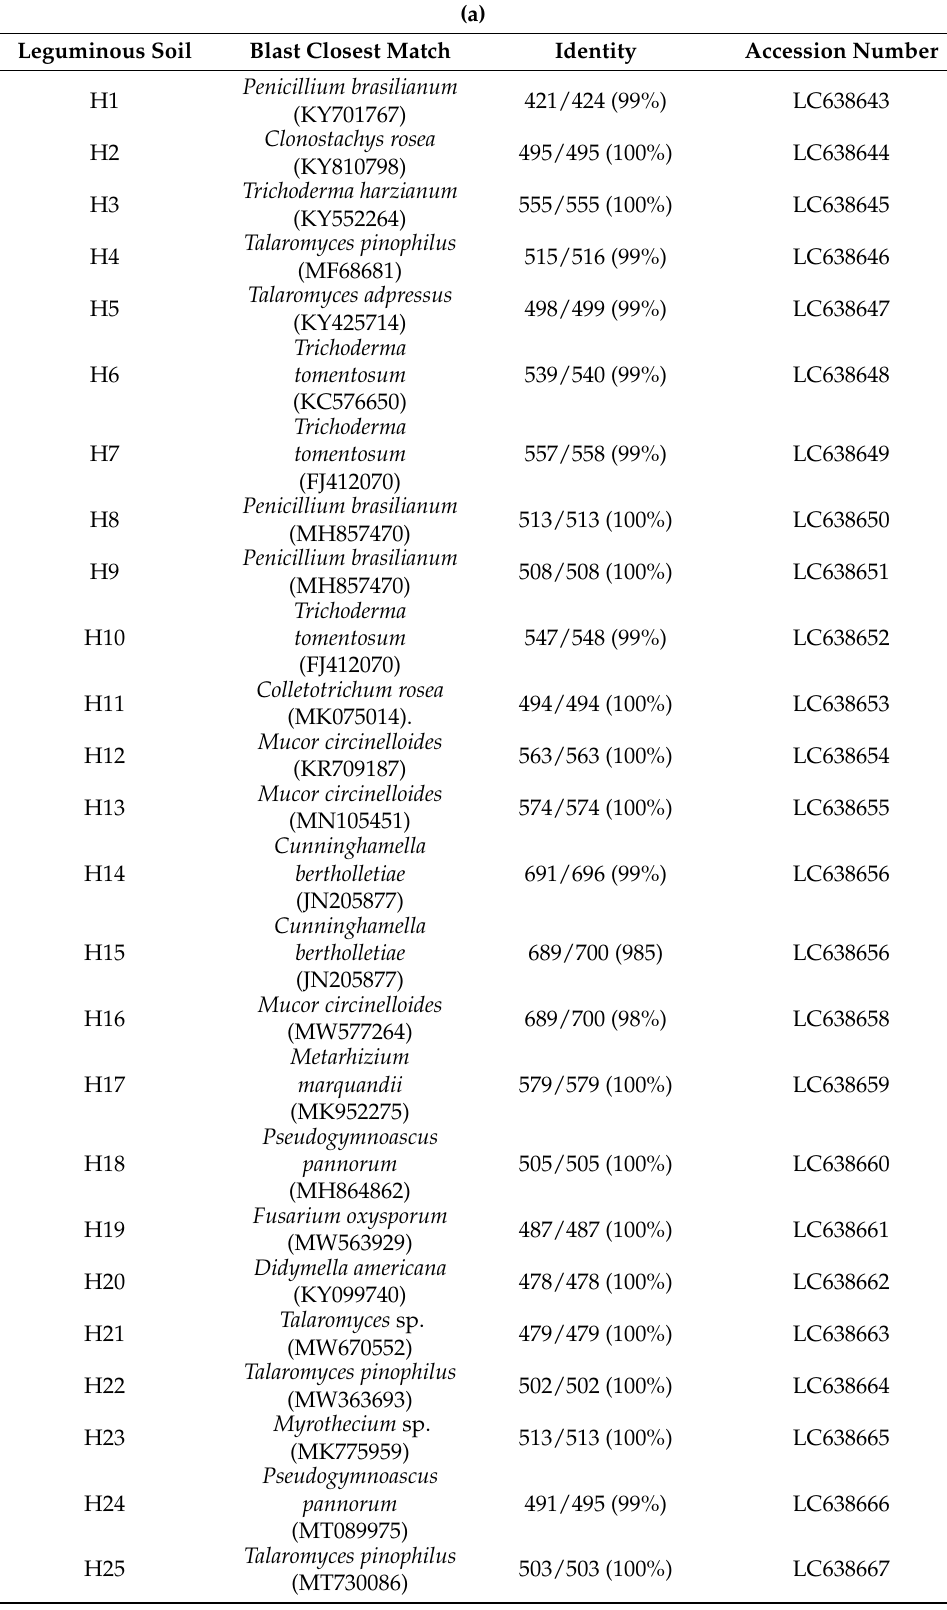
Table 1. ( a ) List of the fungi isolated from the soil incorporated with leguminous plant soil. ( b ) List of the fungi isolated from the soil incorporated with non-leguminous plant